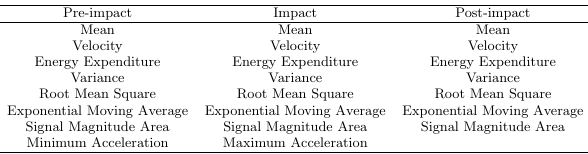
Figure 1: Activities of Daily Living (ADLs) and simulated fall illustration[16] Table 2: Fall stages and their extracted features